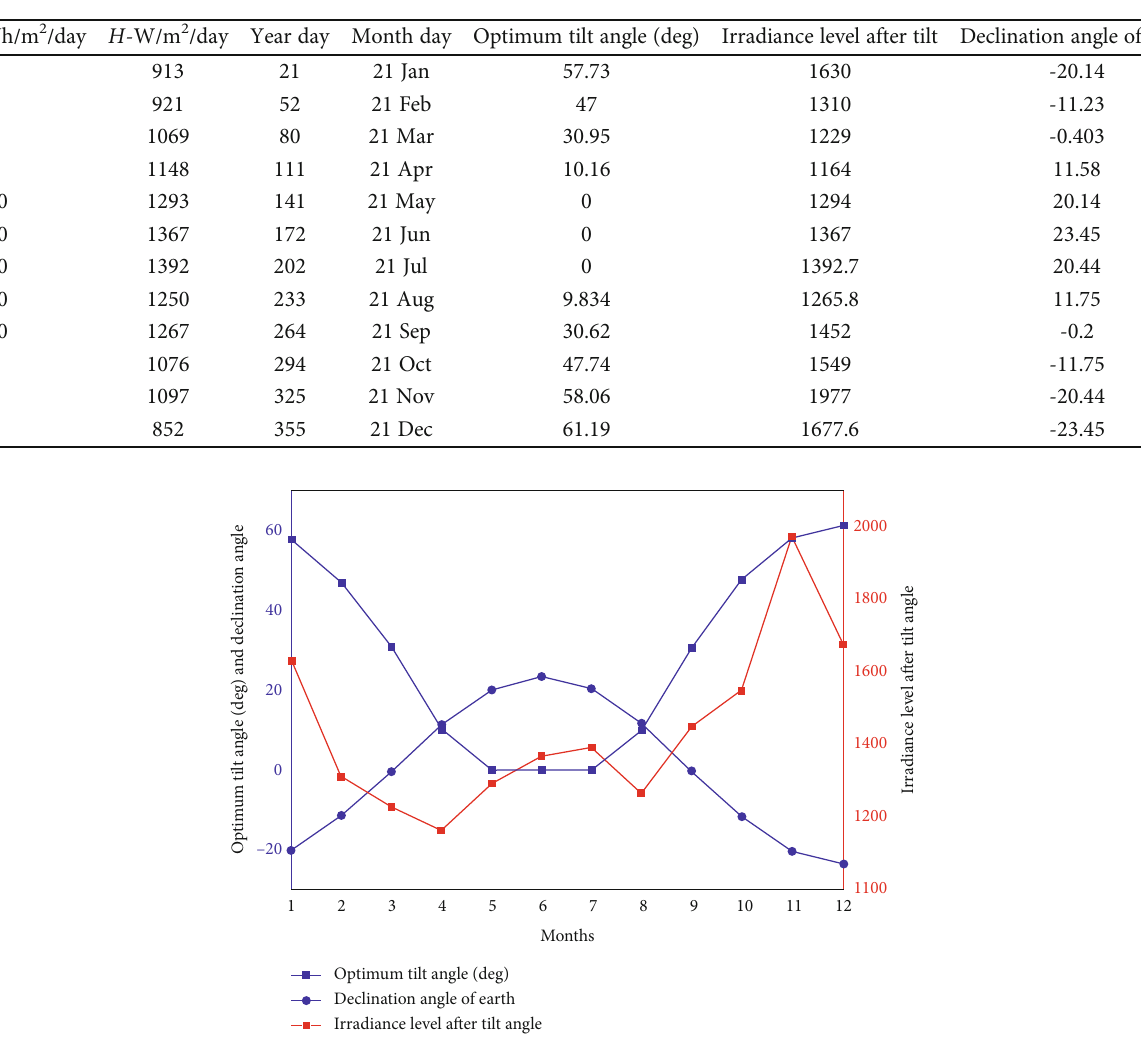
Table 2: Monthly speci fi c daily global irradiance ( H ), year days, days of the month, tilt angle (deg), irradiance level after tilt, and declination angle of the earth.